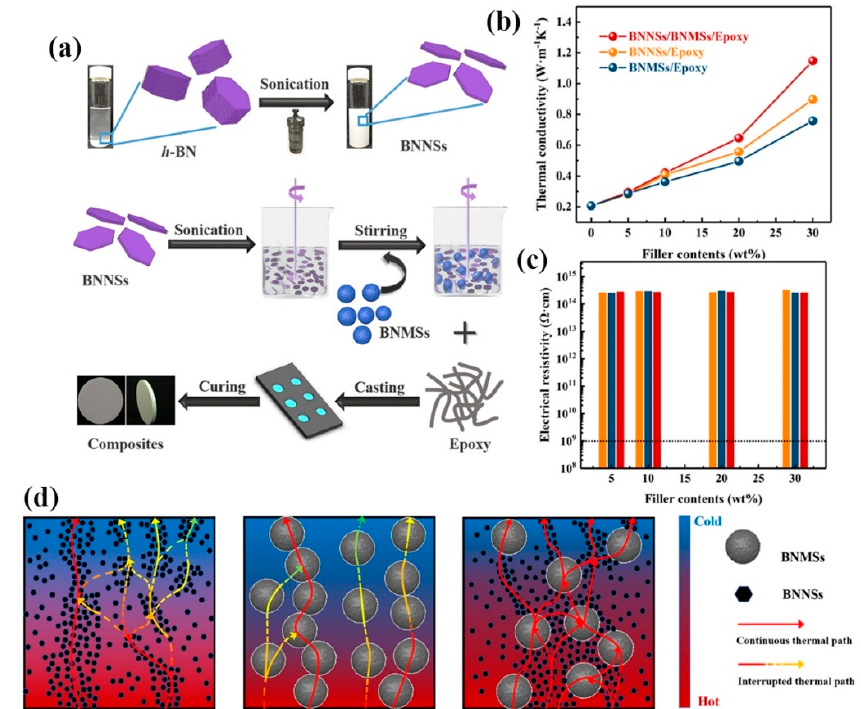
Figure 14. ( a ) Schematic illustration, ( b ) λ , and ( c ) electrical properties of boron nitride microsphere (BNMS)/BNNS/epoxy composites. ( d ) Thermal-conduction pathways in the BNNSs/epoxy, BNMSs/epoxy, and BNNSs/BNMSs/epoxy composites (reproduced with permission from [98]).